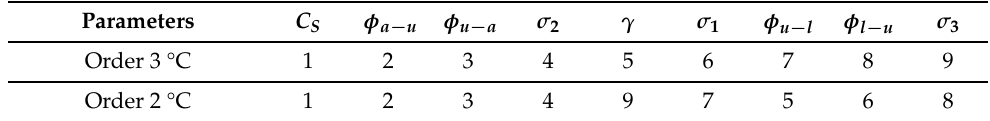
Table 2. Deviation order of uncertain climate parameters.